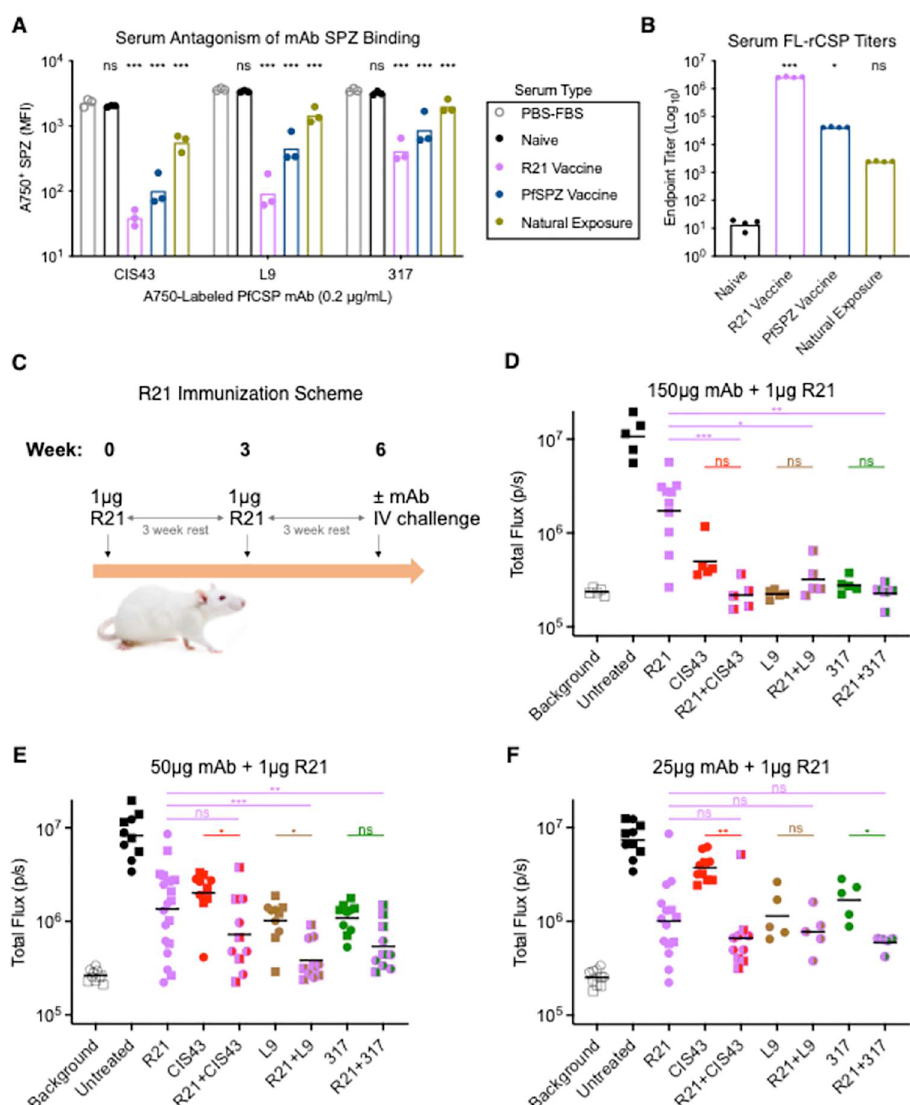
Fig 7. Combining R21 vaccination and passive transfer of PfCSP repeat mAbs provides improved protection against malaria. (A) MFI of Pb-PfCSP-SPZ bound by 0.2 μ g/mL CIS43-, L9-, or 317-AF750 when co-incubated with PBS + 10% FBS (PBS-FBS) or 1:5 diluted serum pooled from either one na ï ve US adult volunteer, ten na ï ve mice immunized 3x with 1 μ g R21 + adjuvant, fifteen na ï ve US adults immunized 3x with 9x10 5 irradiated PfSPZ, and ten Malian children/adults naturally exposed to malaria. For each PfCSP repeat mAb, P- values were determined by comparing each serum type to the PBS-FBS control using a two-way ANOVA with Bonferroni’s post-hoc correction. (B) Endpoint titers of pooled serum from A binding to FL-rCSP measured by ELISA. P- values were determined by comparing serum types to na ï ve serum using the Kruskal-Wallis test. (C) R21 immunization scheme in normal mice, which received two intramuscular injections of 1 μ g R21 + adjuvant at three week intervals prior to passive transfer of PfCSP repeat mAbs two hours before IV challenge with 2,000 Pb-PfCSP-SPZ. (D-F) Liver burden 40 hours after IV challenge with 2,000 Pb-PfCSP-SPZ in mice (n = 5-20/group; 50 μ g/25 μ g data in E/F were combined from two experiments, circles and squares) immunized with 1 μ g R21 alone; mice administered CIS43, L9, and 317 alone (D, 150 μ g; E, 50 μ g; F, 25 μ g); and mice immunized with 1 μ g R21 and administered CIS43, L9, and 317 (D, 150 μ g; E, 50 μ g; F, 25 μ g). P- values were determined by comparing each R21 + mAb combination to the R21 alone or respective mAb alone groups using the Kruskal-Wallis test. (A-B, D-F): ��� , p < 0.001; �� , p < 0.01; � , p < 0.05; ns (not significant), p > 0.05.